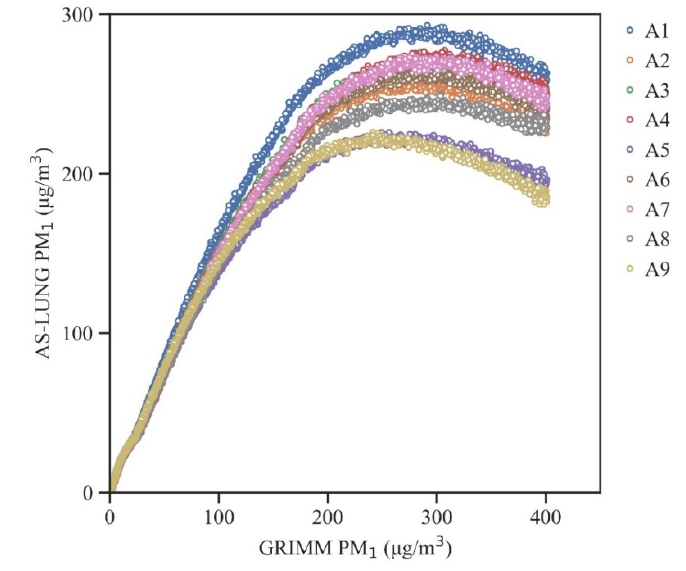
Figure 5. Curves with 0.1–400 µg/m 3 of PM 1 for the nine AS-LUNG-P sets.